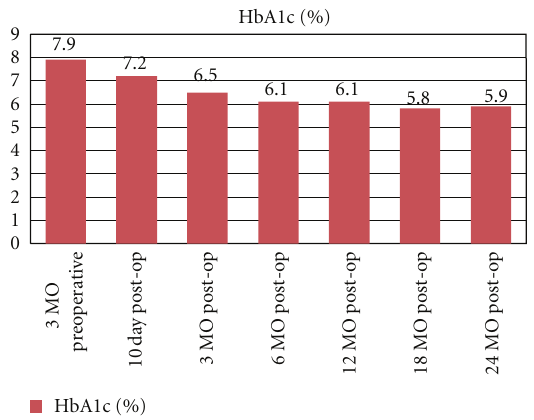
Figure 3: Patient’s HbA1C levels 3 months preoperatively through 24 months